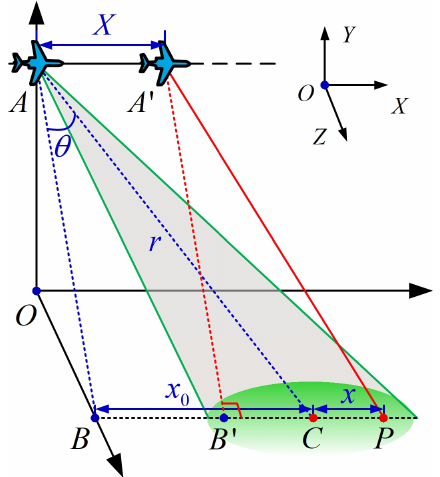
Figure 2. Highly squinted SAR geometric